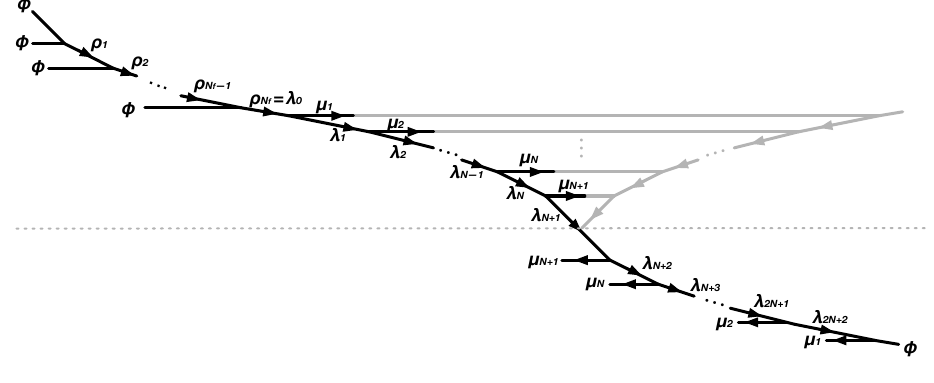
Figure 12 . Strip diagram obtained by reflecting the right half of the 5-brane web